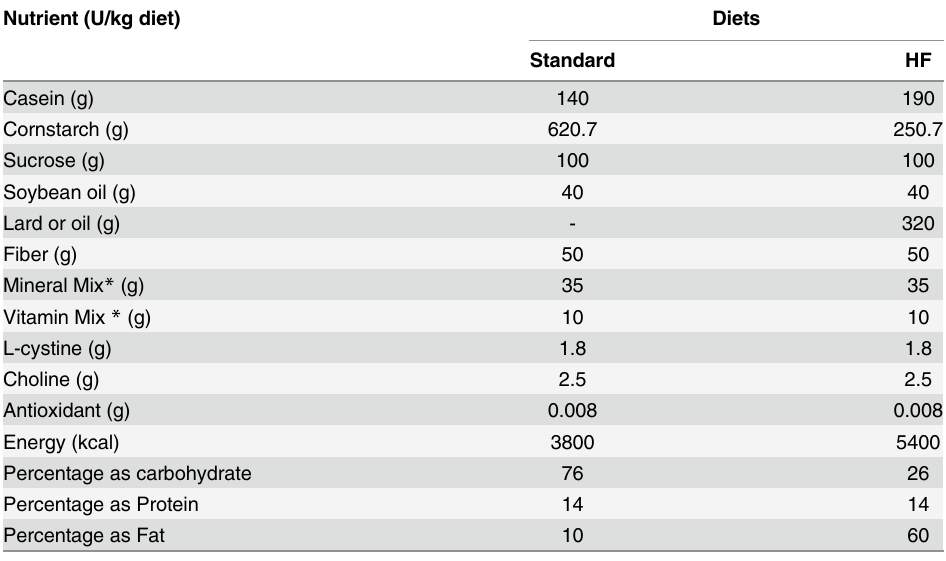
* Vitamins and minerals mix following the AIN-93M recommendation for